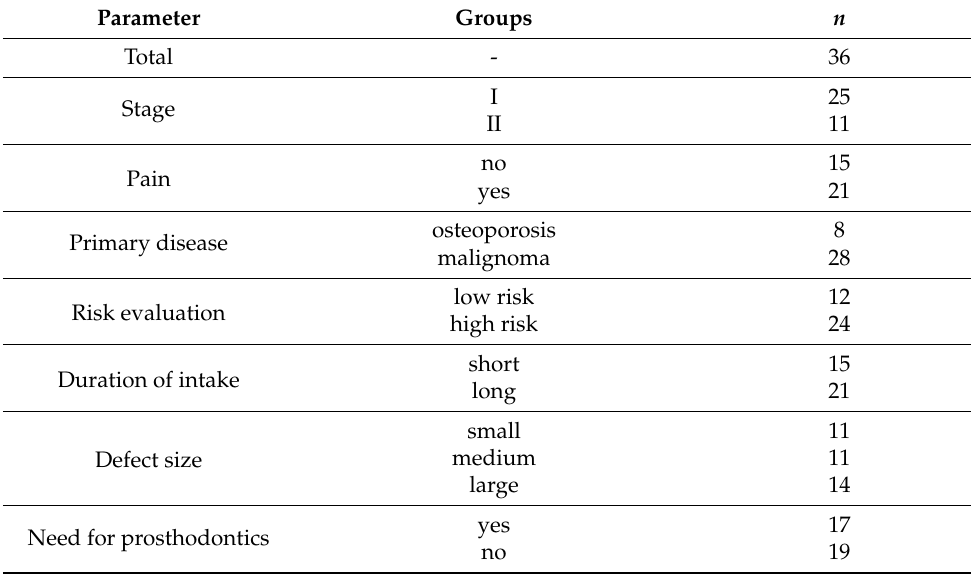
Table 2. MRONJ-related parameters in the different